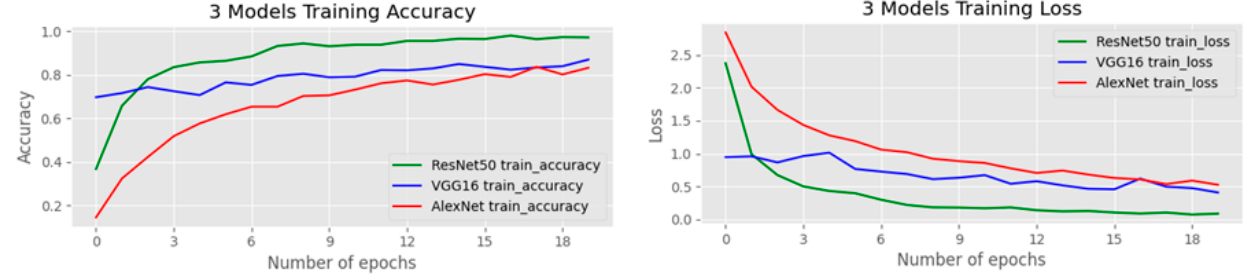
Figure 5. Comparison of the training accuracy and training loss on the OGED dataset.